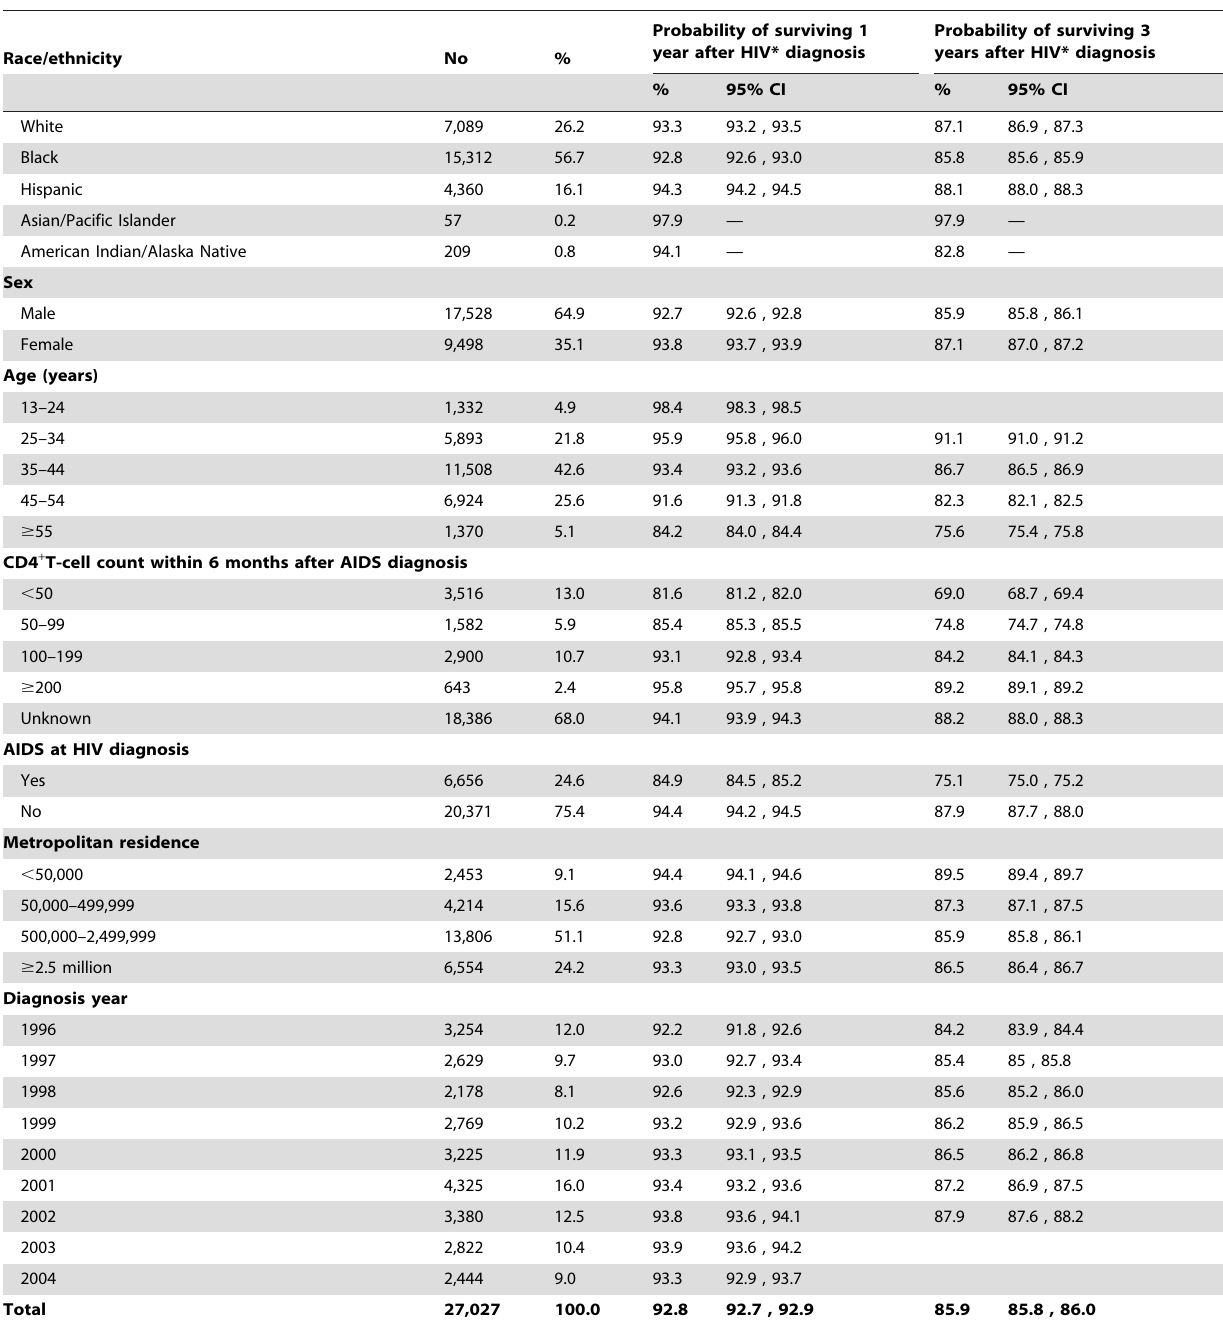
Estimates are from standardized Kaplan-Meier survival analyses, adjusted for all other factors shown in the table. * Diagnosis of HIV infection with or without a concurrent diagnosis of AIDS. Dash indicates data not presented because the variance for the estimate is zero.